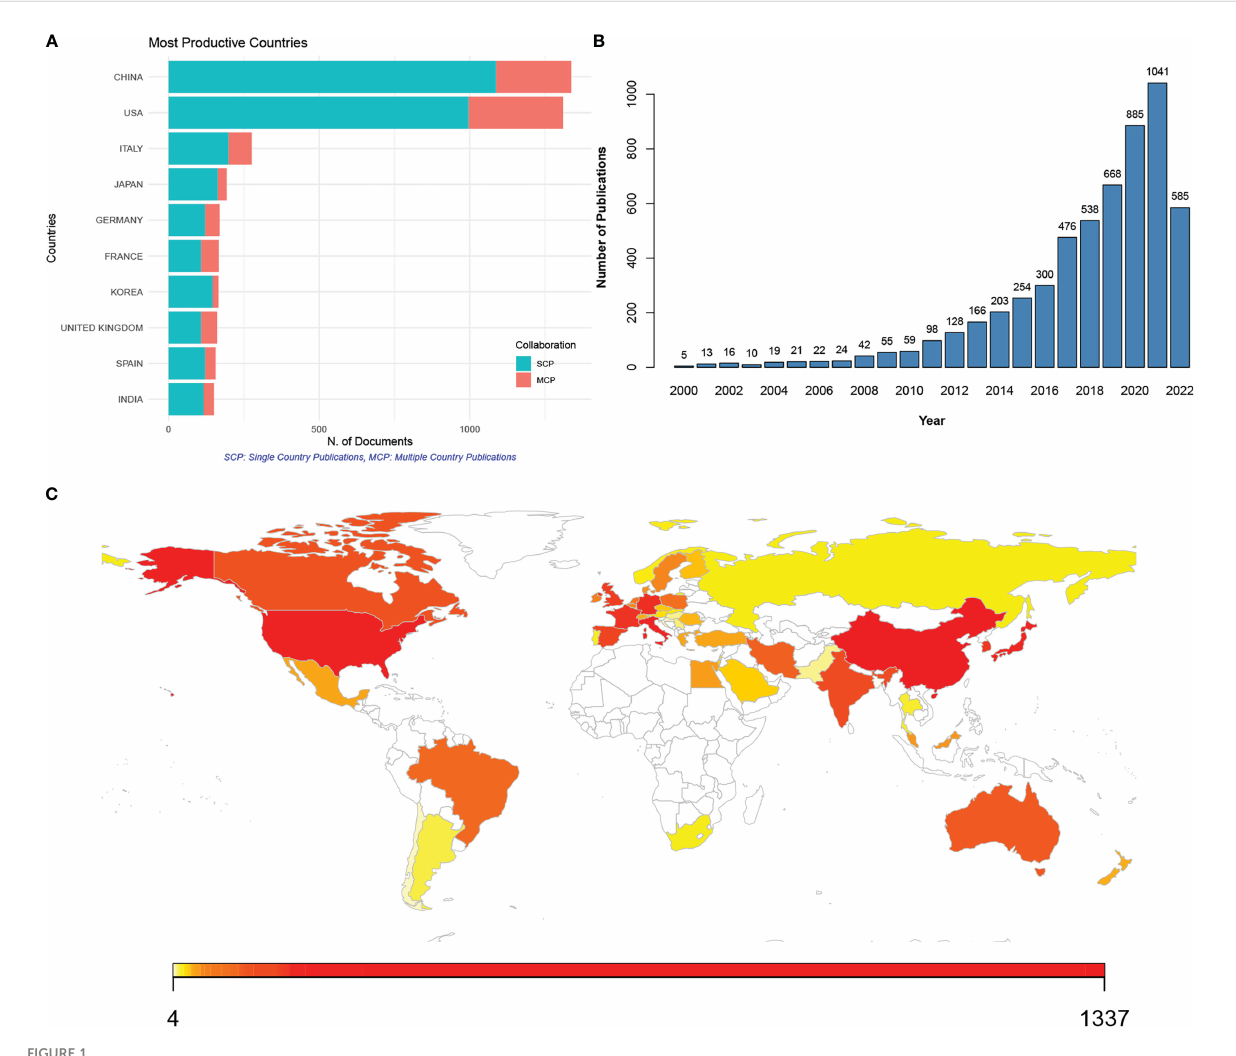
FIGURE 1 Publications of studies on the gut microbiome associated with colorectal cancer (CRC) from 2000 to 2022. (A) Top 10 countries with most publications of gut microbiome in CRC; SCP (green), single country publication; MCP (red), multiple country publication; (B) annual publications from 2000 to 2022; (C) contributing countries visualized by map; the number of publications was marked by color, with red to yellow indicating high to low